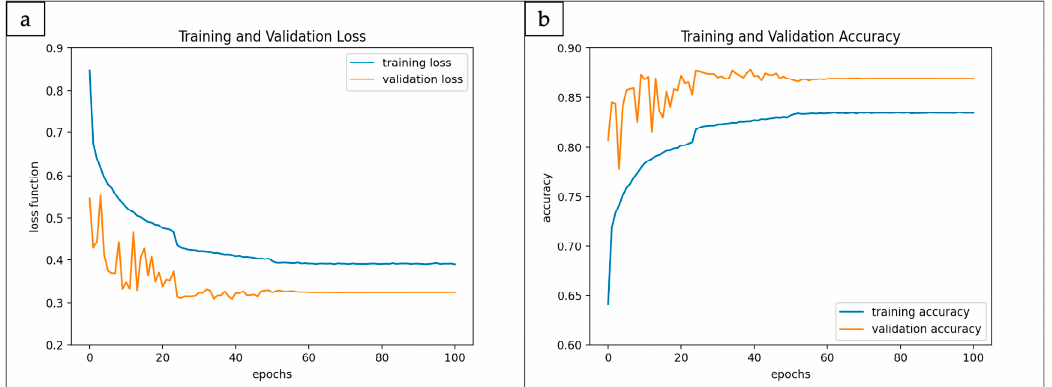
Figure 2. ( a ) The loss function minimization; ( b ) the accuracy trend; training and validation cases were plotted. Only the first 100 epochs were plotted because the network achieved its best performance around this level.